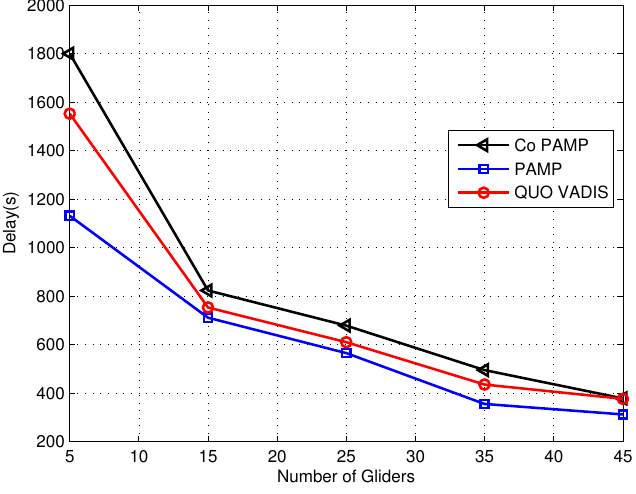
Figure 10. End-to-end delay comparison.